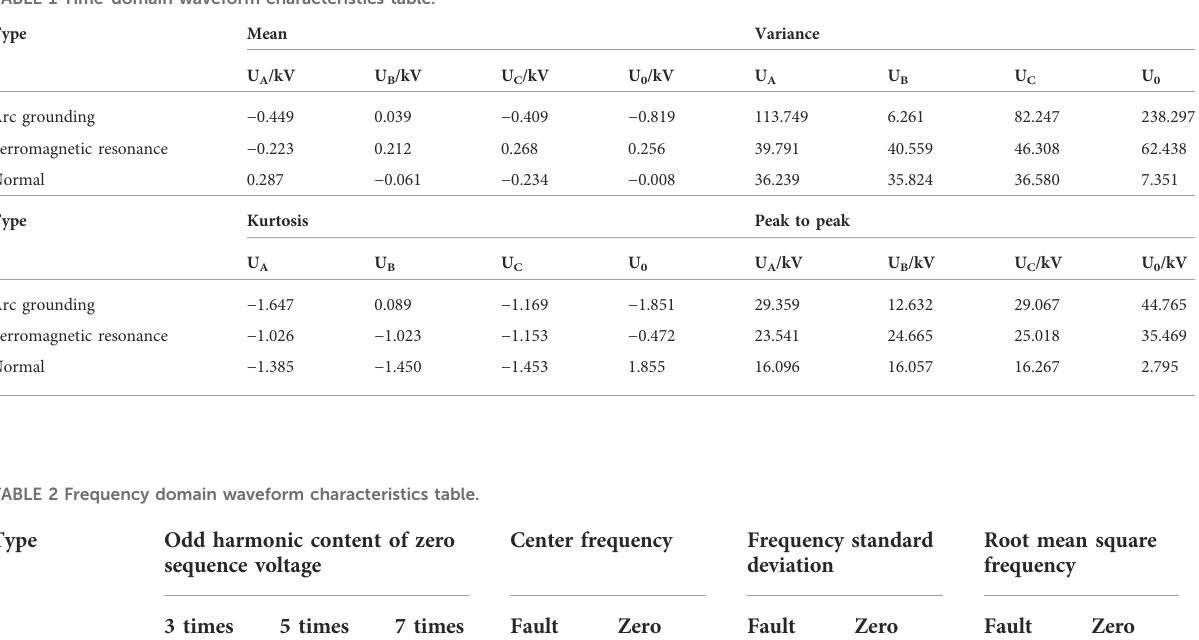
TABLE 1 Time-domain waveform characteristics table.